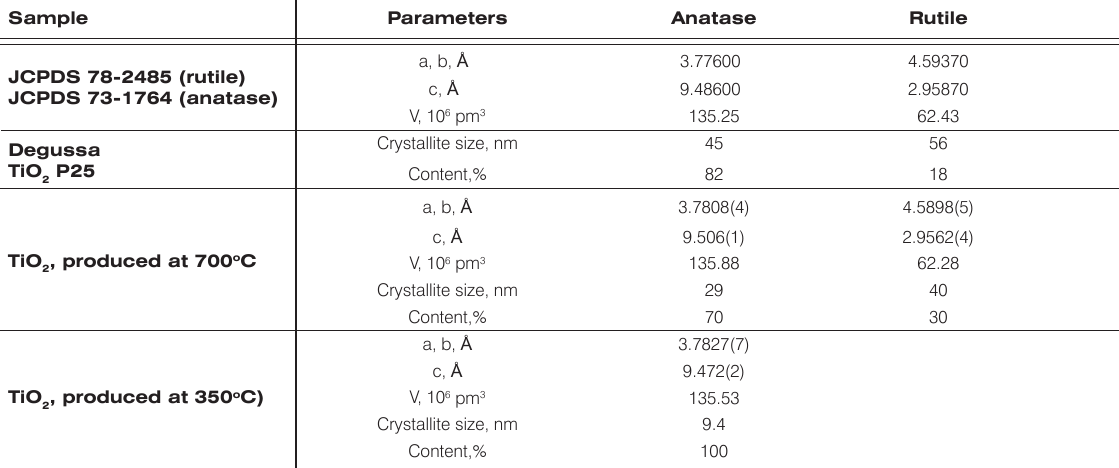
Table 2. Lattice parameters, size of crystallites and phase composition of the studied